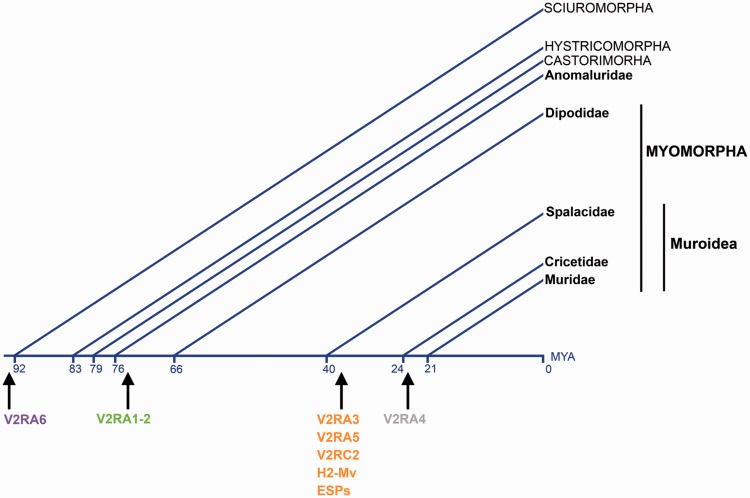
Origins of the pheromone-related genetic components in the basal VNO neurons. Divergence times, in MYA, are based on Hedges et al. (2006).